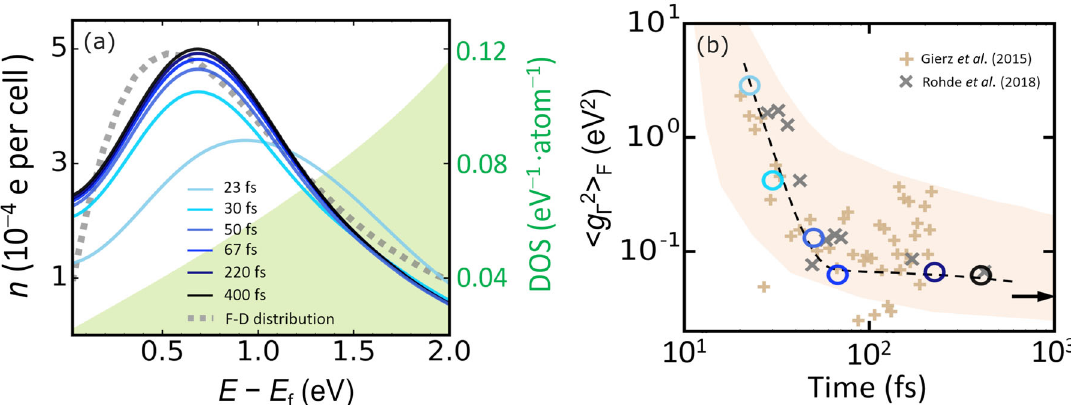
Fig. 5 Tracking the ultrafast EPC in real time. a The energy distribution of different EECs states in the undoped graphene where the Fermi level locates at the Dirac point i.e., E f = E D . The grey dashed line labels the Fermi-Dirac distribution at T e = 5000 K. The yellow green shade (cid:1) (cid:3) as a function of time. The tan and grey crosses label the effective g 2 Γ shows the electronic density of states (DOS). b The effective g 2 Γ F extracted from dynamic carrier states measured experimentally in ref. 44 and ref. 42 . The tan shadow and black dashed line are guides to eyes. (cid:1) (cid:3) (cid:1) (cid:3) The arrow labels the value of g 2 Γ in equilibrium where g 2 Γ ~0.05 eV 2 F F line. As time goes on, the peak of excited-carrier distribution moves from the high energy region to the low energy region and fi nally approaches the F-D distribution, beaconing the cooling down process of hot carriers. laser fl uence of ~44 μ J ∙ cm − 2 and analyse the ultrafast EPC during The corresponding time evolution of effective EPC matrix (cid:1) (cid:3) is shown in Fig. 5b (Also in Supplementary Fig. 1 for element g 2 Γ different time n e ( E − E f , t ). For comparison, the F-D distribution F doping case). With photoexcitation ( t ≤ 30 fs), the carriers are with an electron temperature T e ~5000 K is marked by grey dash